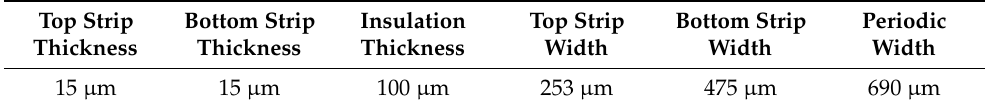
Figure 7. Photograph of XS anode. Table 1. Design parameters of XS anode.